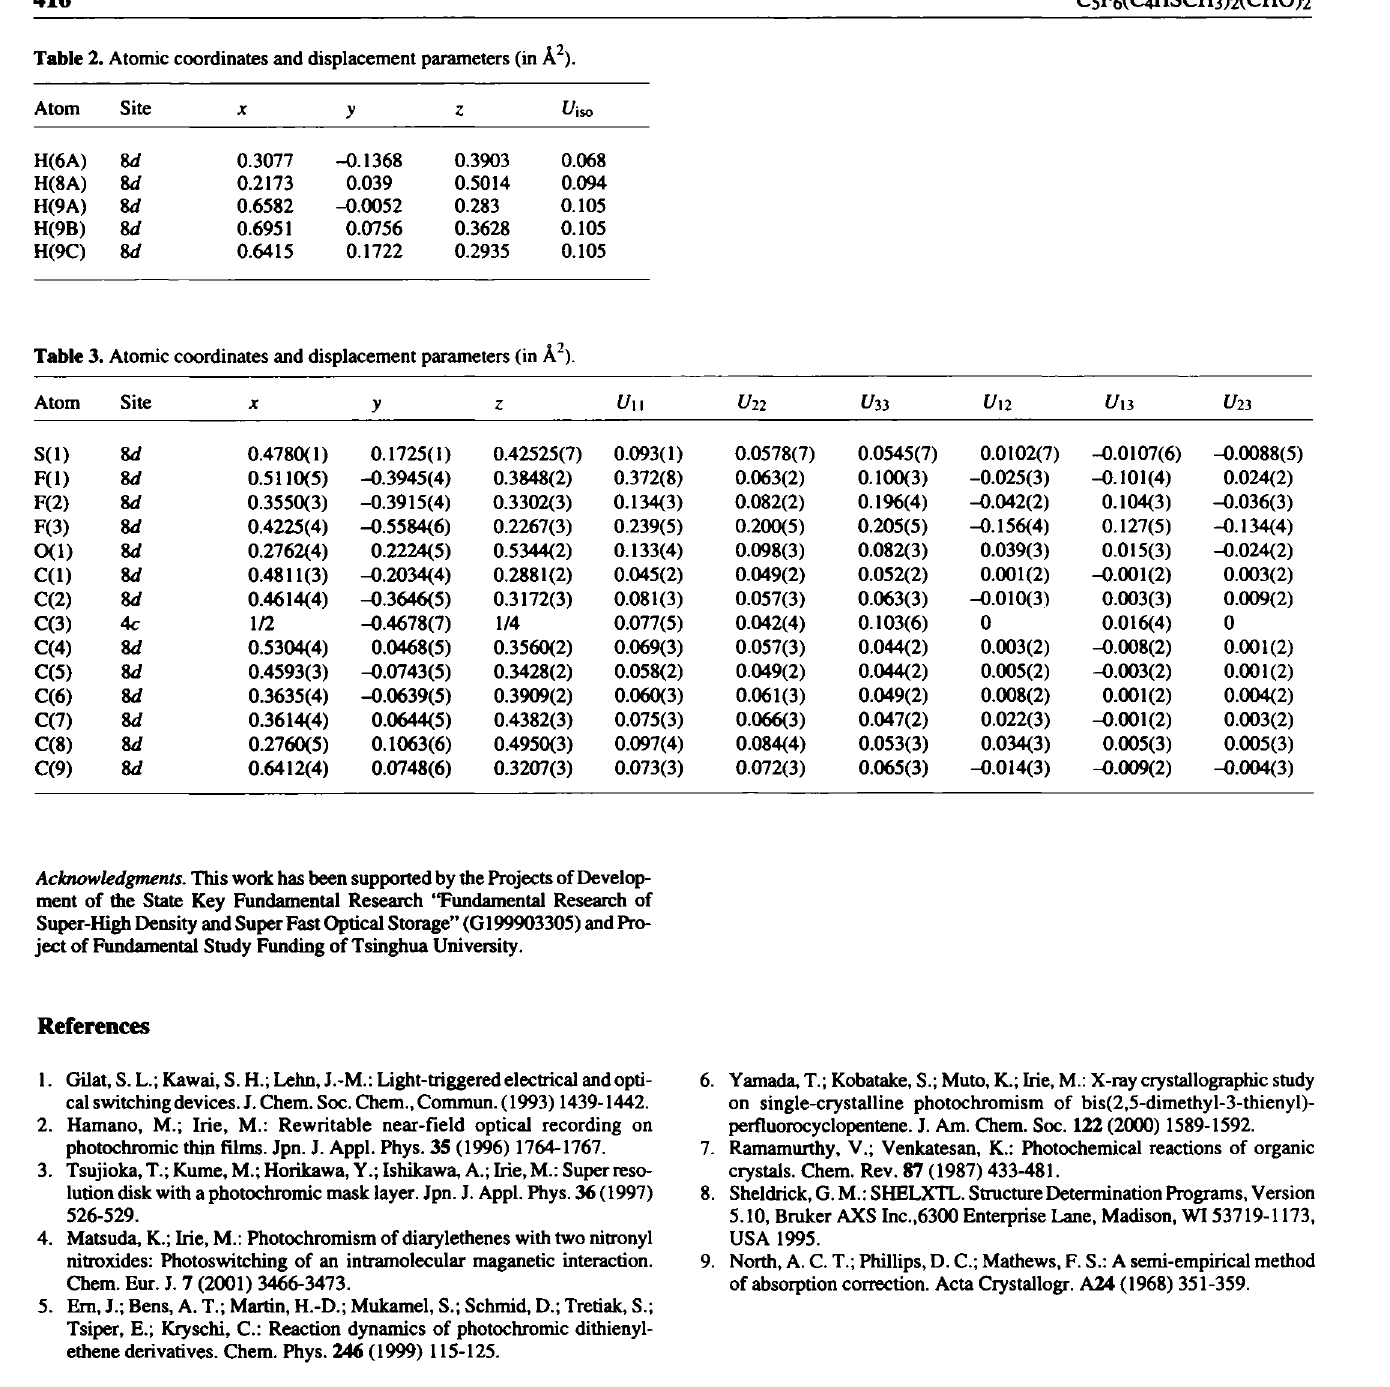
Table 2. Atomic coordinates and displacement parameters (in A 2 ).